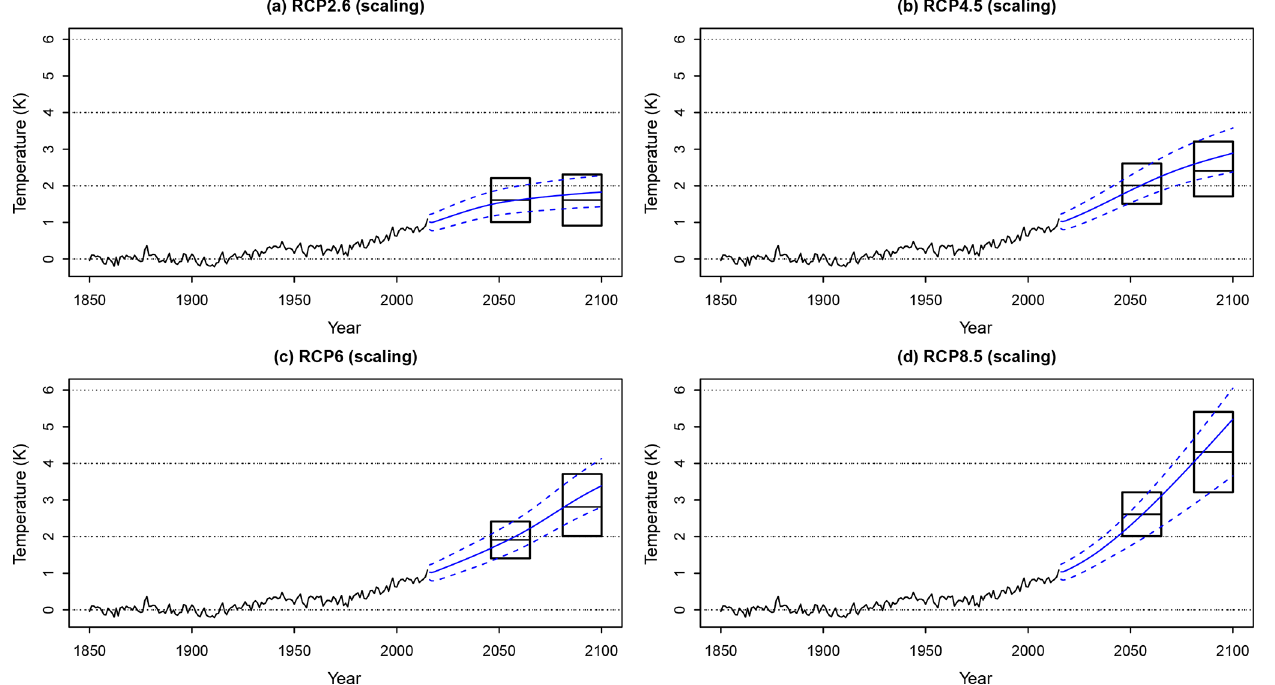
Figure 4. Panels (a) – (d) describe the marginal posterior means and 95% credible intervals of the predicted temperature response to fu- ture forcing according to the RCP2.6, RCP4.5, RCP6, and RCP8.5 trajectories, respectively, using a scaling response function. These are compared to the AR5 projections (black